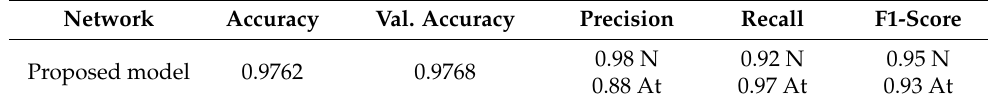
Table 9. BDLSTM-autoencoder model results for DDoS detection of an emulated test of the BDLSTM-autoencoder model.